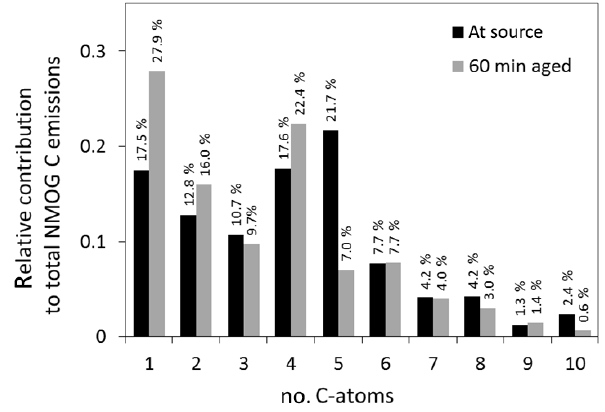
Figure 10. Relative contributions of C 1 to C 12 compounds to total NMOG carbon measured at the fire source and at the 1h downwind